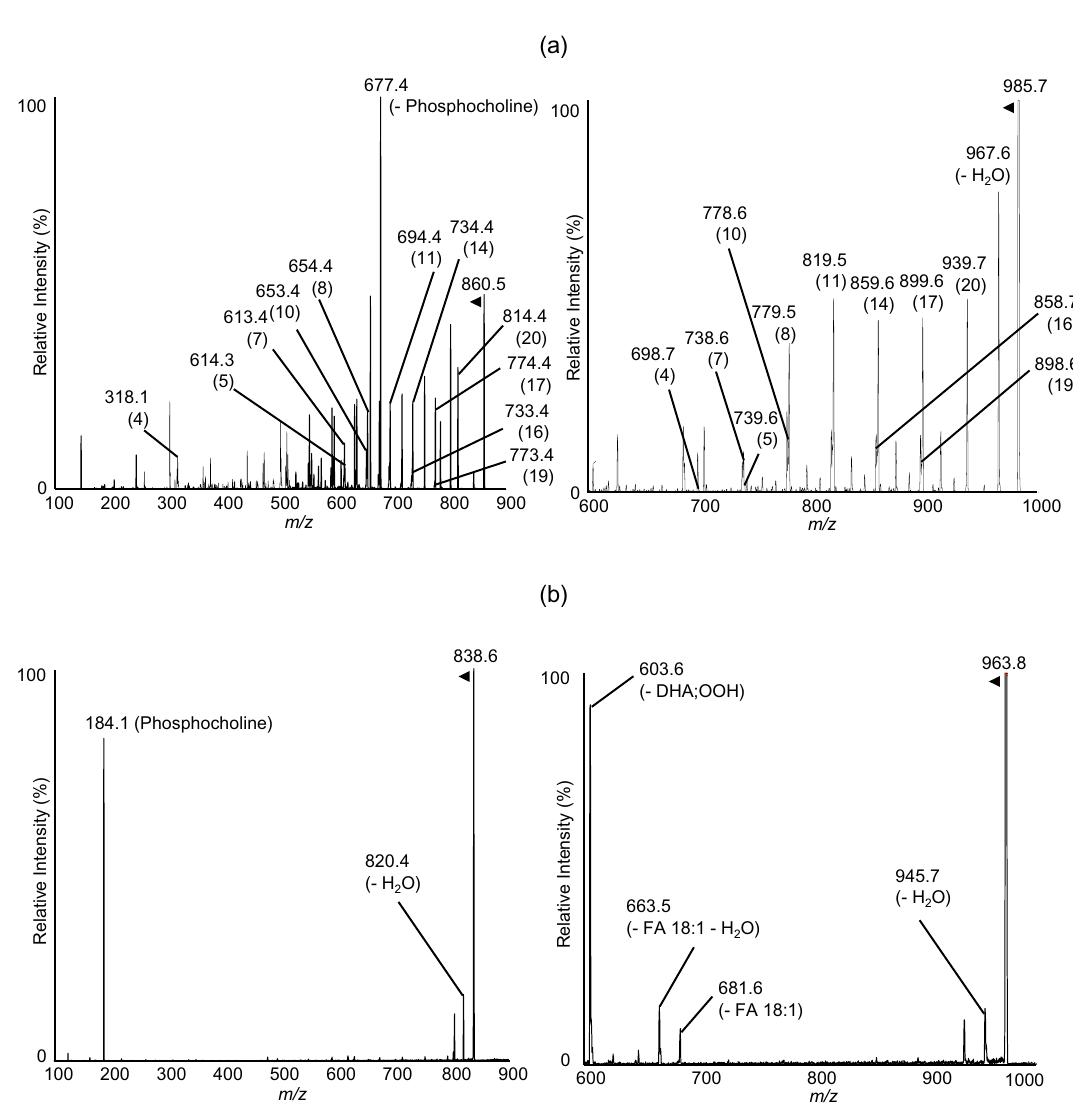
Figure 3. ( a ) Product ion scan of Na + adduct of PC 16:0/22:6 (left) and TG 18:1_18:1_22:6 (right) in the model samples. ( b ) Product ion scan of H + adduct of PC 16:0/22:6 (left) and TG 18:1_18:1_22:6 (right) in the model samples. Na + adduct of PC 16:0/22:6;OOH showed product ions derived by the dissociation of phosphocholine or trimethylamine with the isomer-specific neutral